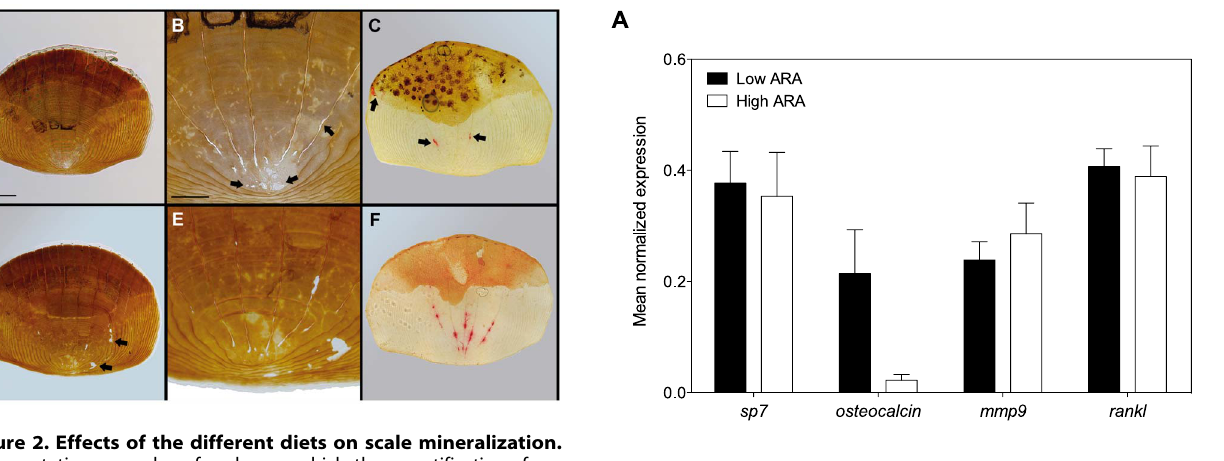
Figure 2. Effects of the different diets on scale mineralization. Representative examples of scales on which the quantifications from Figure 1 were based. A : Example of a scale from the low ARA group stained for mineralization (Von Kossa staining, calcium phosphates stained brown). The scale is almost completely mineralized and the brown staining is only absent in the focus (lower central region) of the scale. Bar=250 m m. B : Detailed image of the focus of the scale shown in ( A ) with several unmineralized small resorption pits where staining is absent (arrows). Bar=100 m m. C : TRAcP activity-stained ontogenetic scale from the low ARA group with few red-stained areas positive for TRAcP activity, indicated by arrows. Bar=250 m m. D : Von Kossa stained ontogenetic scale from the high ARA group. Arrows indicate resorption pits outside the focus, seen more often in scales from high than from low ARA fed fish. Bar=250 m m. E : Detailed image of the scale shown in ( D ) with more resorption pits with typical round edges as a result of osteoclastic matrix degradation. Bar=100 m m. F : TRAcP activity-stained ontogenetic scale from the high ARA group with more spots stained red for TRAcP activity than in the low ARA group, indicating the presence of more osteoclasts in this group. Bar=250 m m.